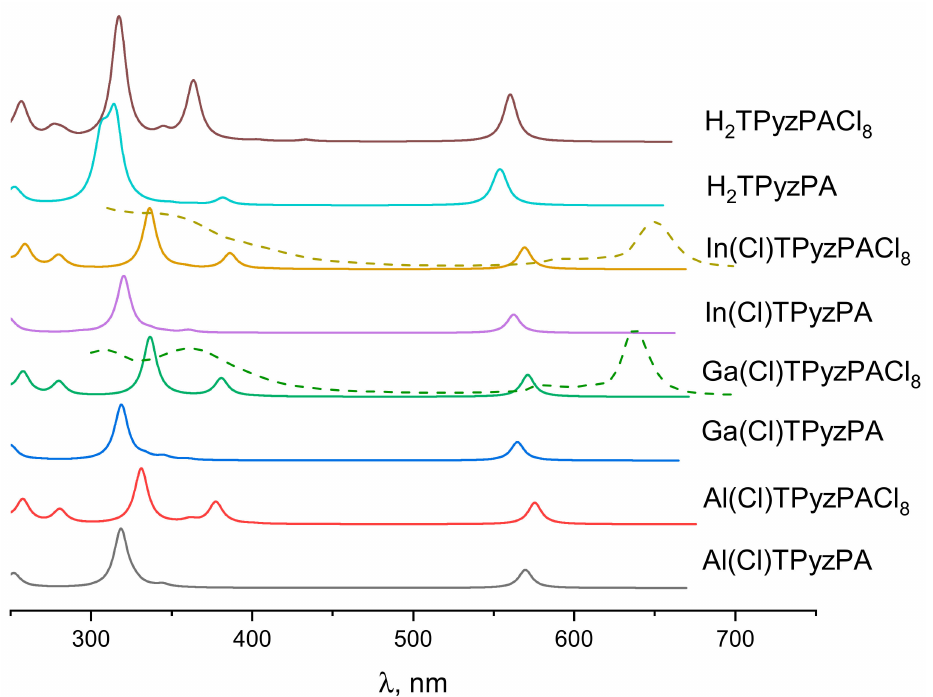
Figure 3. Simulated (solid lines) and experimental (dashed lines) electronic absorption spectra for M(Cl)TpyzPA and M(Cl)TPyzPACl 8 (M = Al, Ga, In) and its metal-free